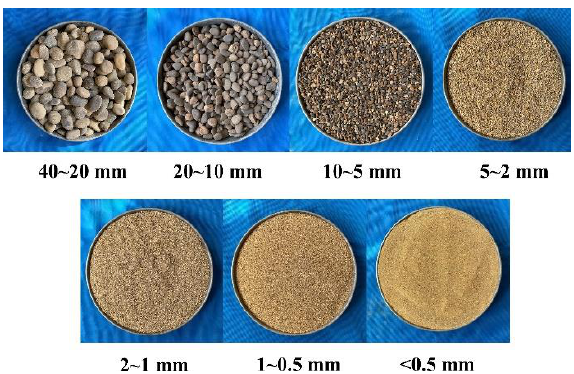
Figure 3. Sandy-gravel soil samples of different gradation groups.